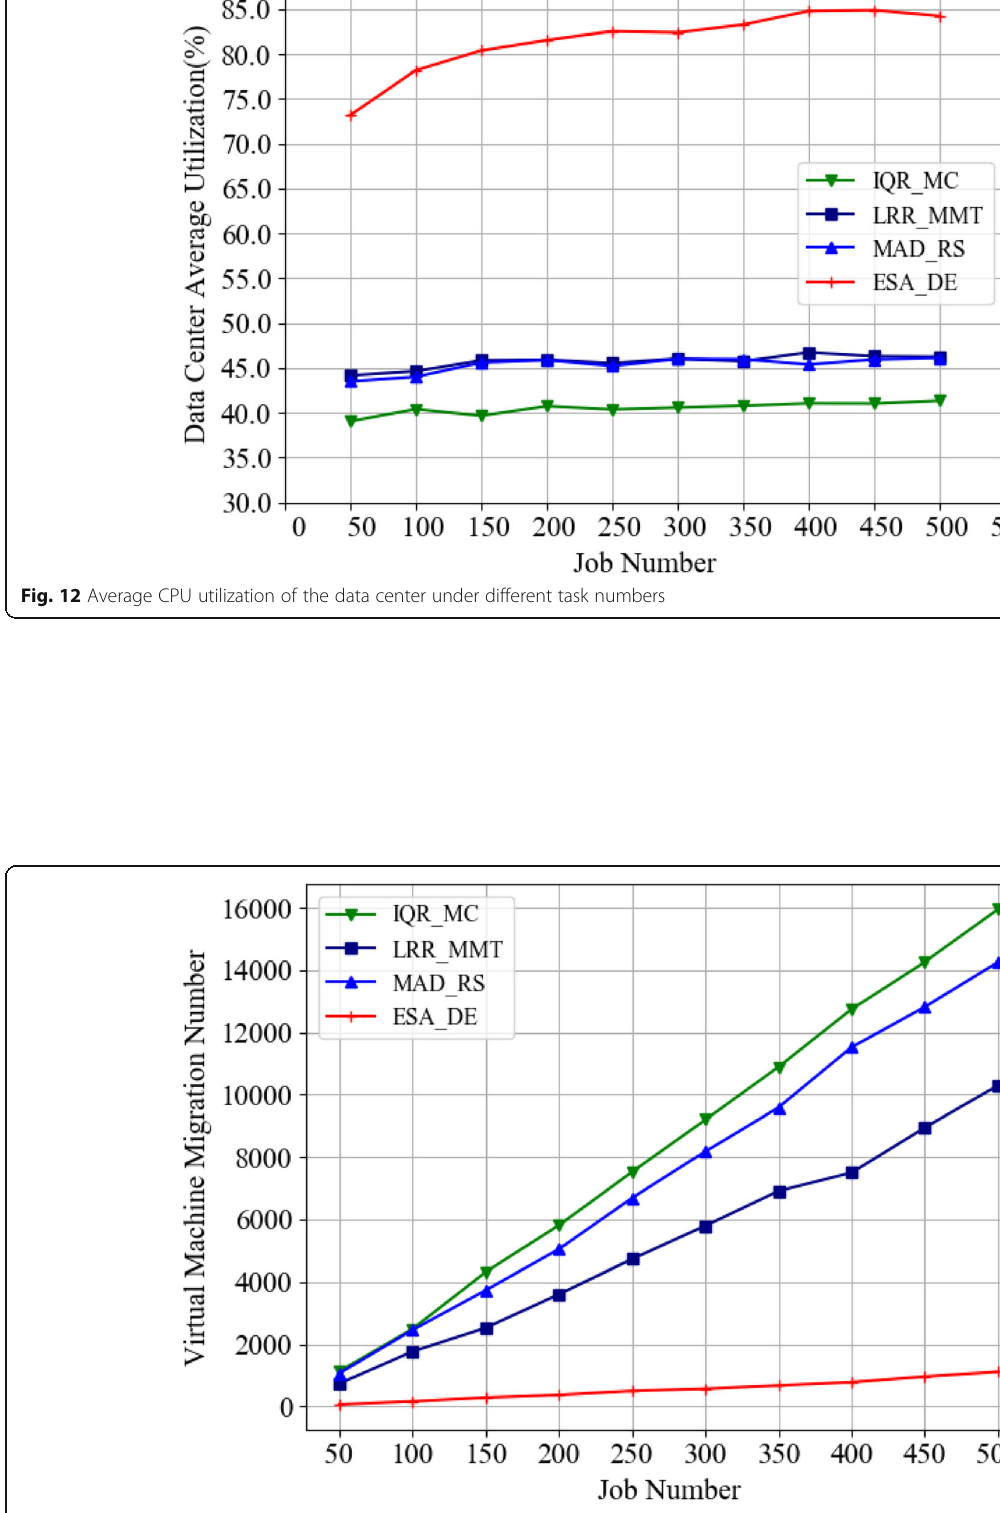
Fig. 13 Virtual machine migration number under different task